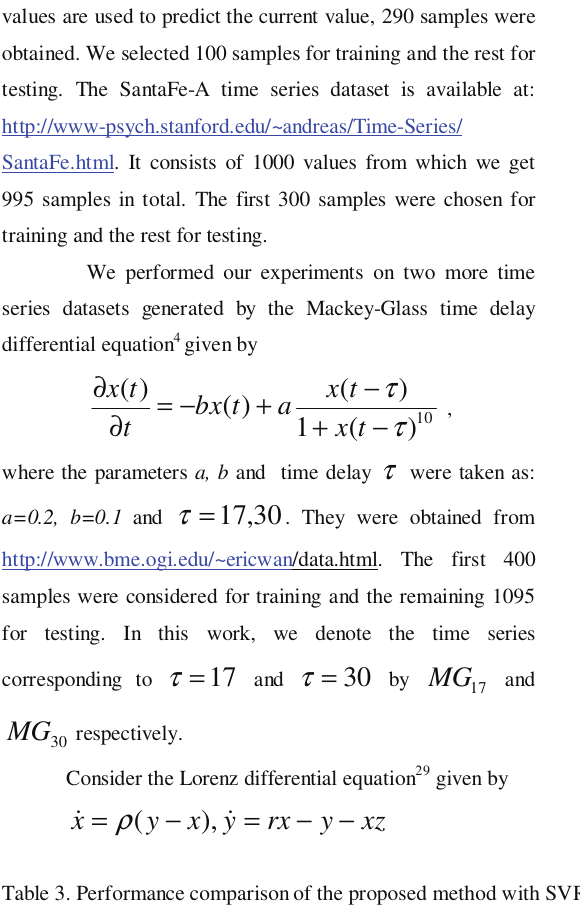
Table 3. Performance comparison of the proposed method with SVR and TSVR on real world datasets. RMSE and training time (seconds) were used for comparison. Gaussian kernel was employed. Bold type shows the best result.